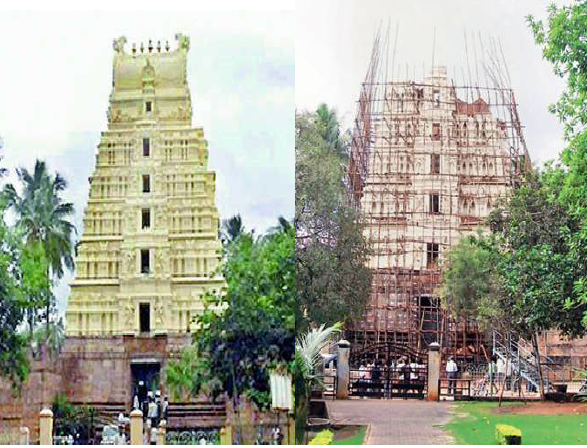
Figure 5 Shivaji gopuram – before and after collapse (indiatemplesinfo,